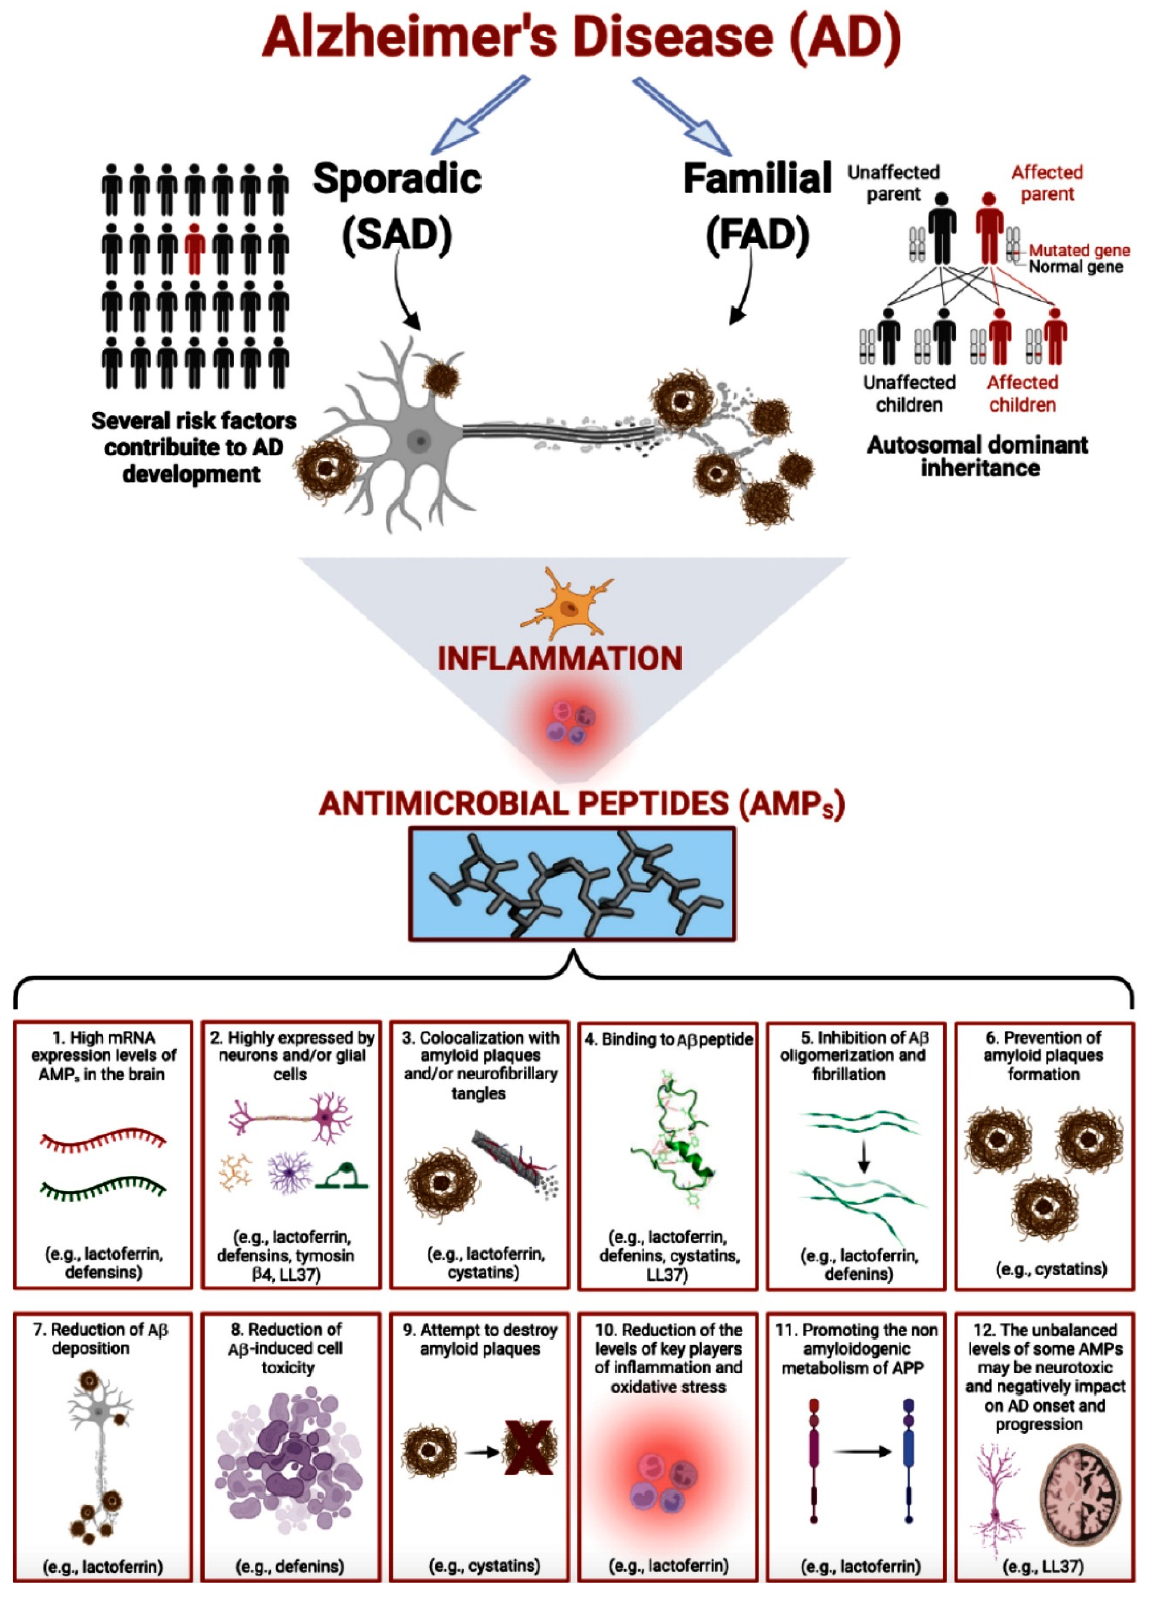
Figure 1. AMPs involvement in AD. Figure 1.